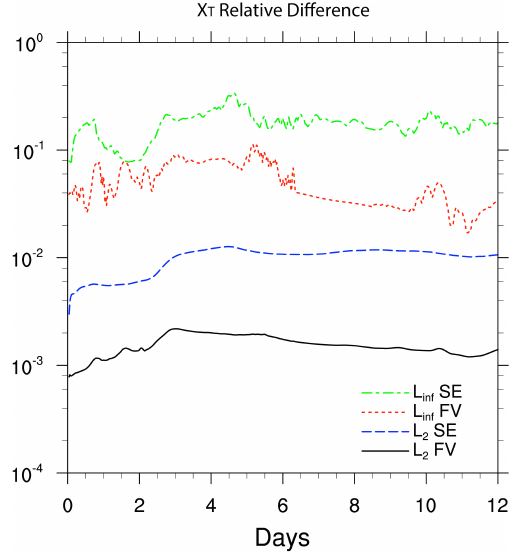
Figure 7. Time evolution of standard error norms (cid:96) 2 and (cid:96) ∞ for X T using the CAM-FV and CAM-SE dynamical cores. Note that the y axis is